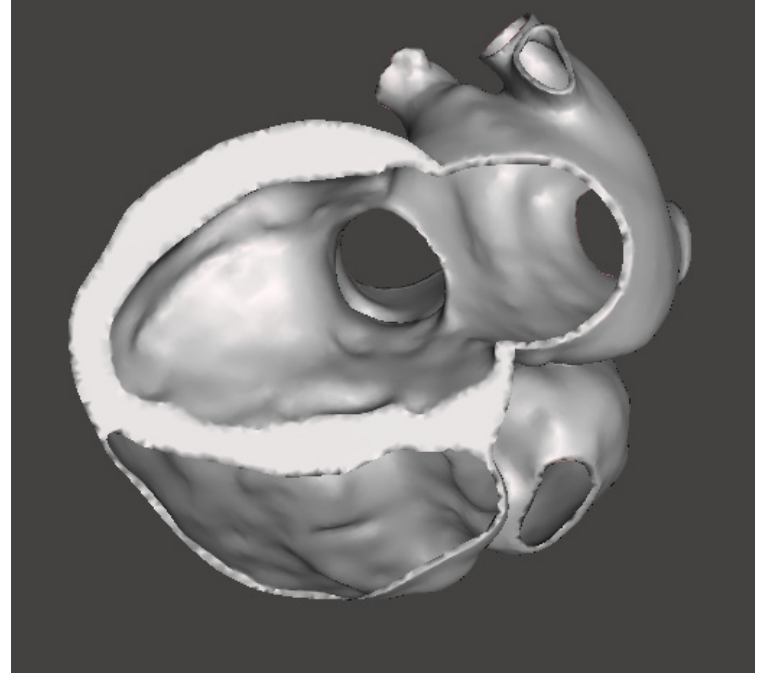
Figure 4. Section view of the reconstructed heart model, in which we can appreciate the realistic variable wall thickness.